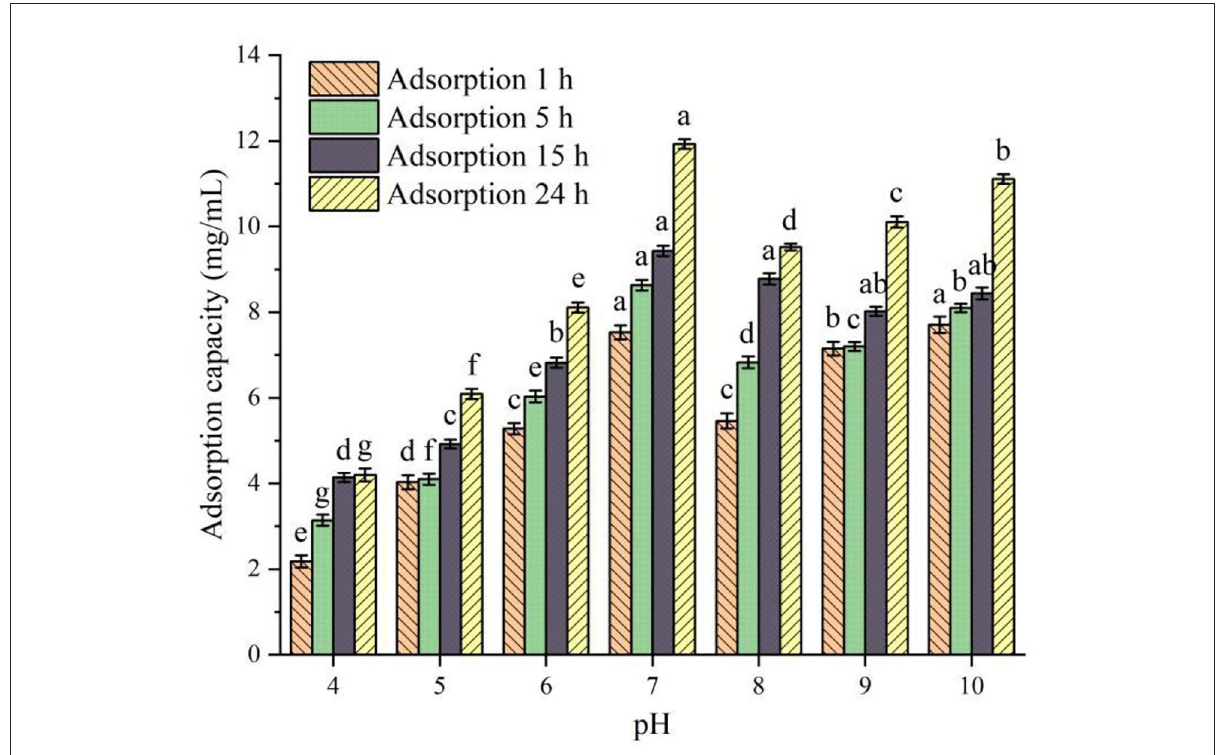
FIGURE2 Adsorption capacity of PSKB protein hydrolysate at different pH values. There is a significant difference between different small letters ( P < 0.05).